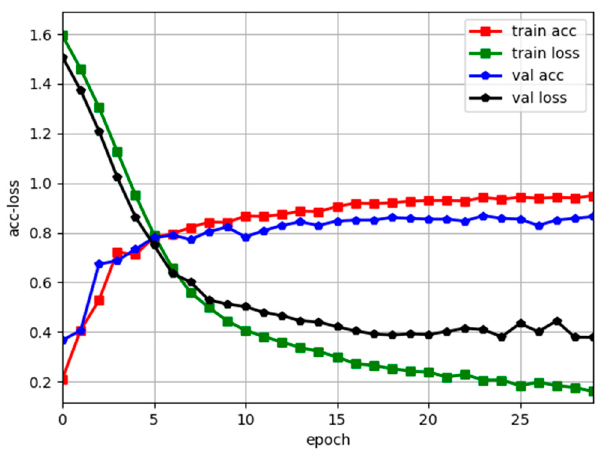
Figure 8. Training results.